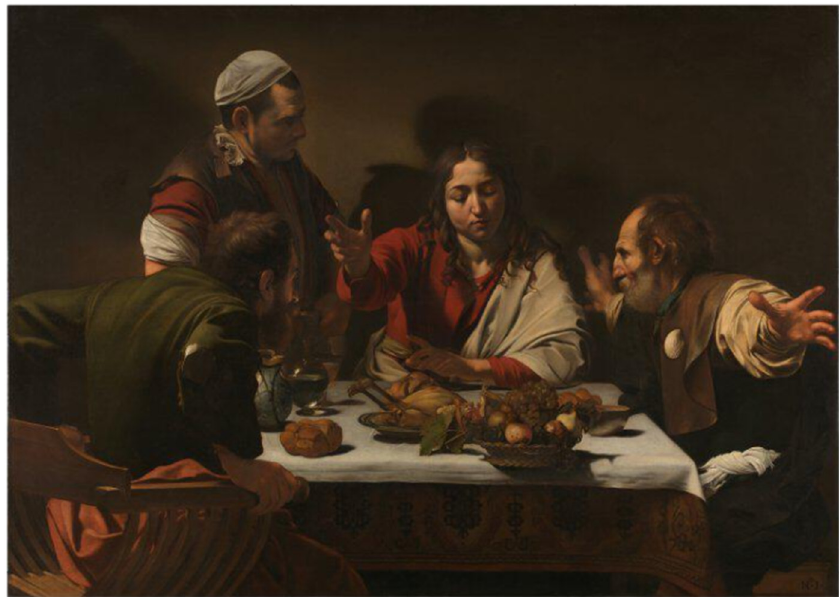
Figure 8. Michelangelo Merisi da Caravaggio’s Supper at Emmaus of (Caravaggio 1601). The National Gallery, London online, https://www.nationalgallery.org.uk/paintings/michelangelo-merisi-da-caravaggio-the-supper-at-emmaus, (accessed on 31 May 2022).